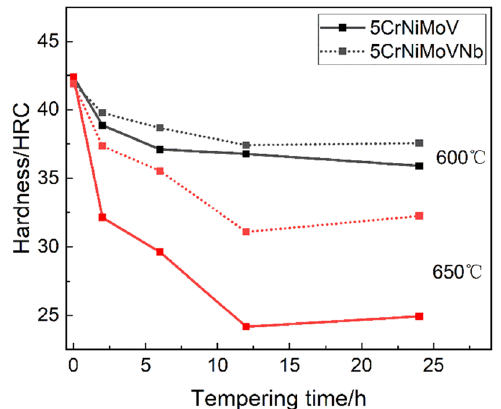
Figure 3: The dependence of hardness in 5CrNiMoV and 5CrNiMoVNb steels on tempering time and temperature.